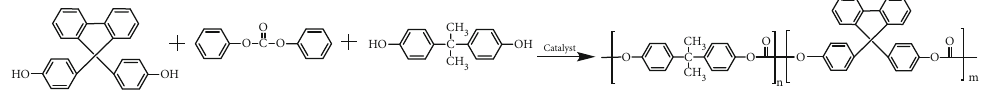
Scheme 1: Reaction equation of PC from BPA, BHPF, and DPC.